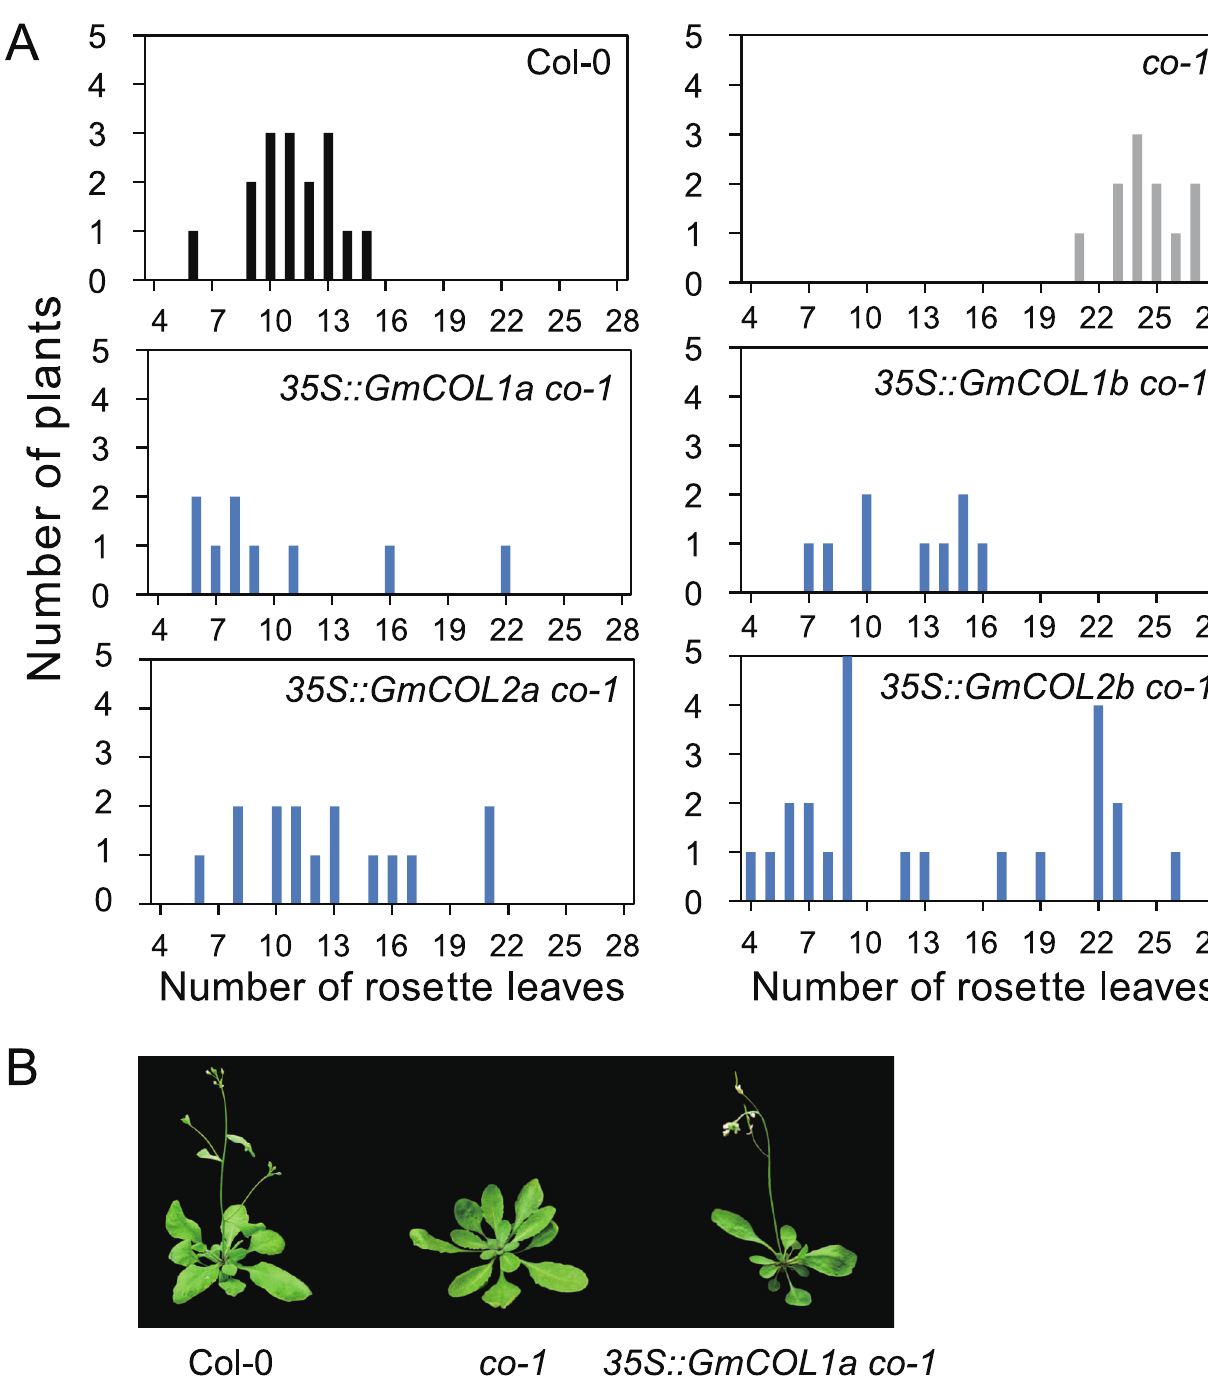
Figure 7. Overexpression of GmCOL1a, GmCOL1b, GmCOL2a and GmCOL2b rescued the late flowering phenotype of Arabidopsis co-1 mutant. (A) The vertical axis indicates the number of T1 transgenic plants, and the horizontal axis indicates the number of rosette leaves. (B) Col-0 (left), co-1 mutant (middle) and co-1 mutant overexpressing GmCOL1a (right). doi:10.1371/journal.pone.0085754.g007 visualization created by Weblogo (Crooks et al., 2004). CO homologs in Clade II do not contain B-box 2. Figure S1 Comparison of B-box 1, B-box 2 and CCT domains of COL homologs. Amino acid sequences of B-box 1, Figure S2 mRNA abundance of Glyma06g23026/E1, B-box 2 and CCT domains of COL homologs in Clades I, II and III in Arabidopsis (At) and soybean (Gm) are compared. Conserved amino acids are shown in large characters for